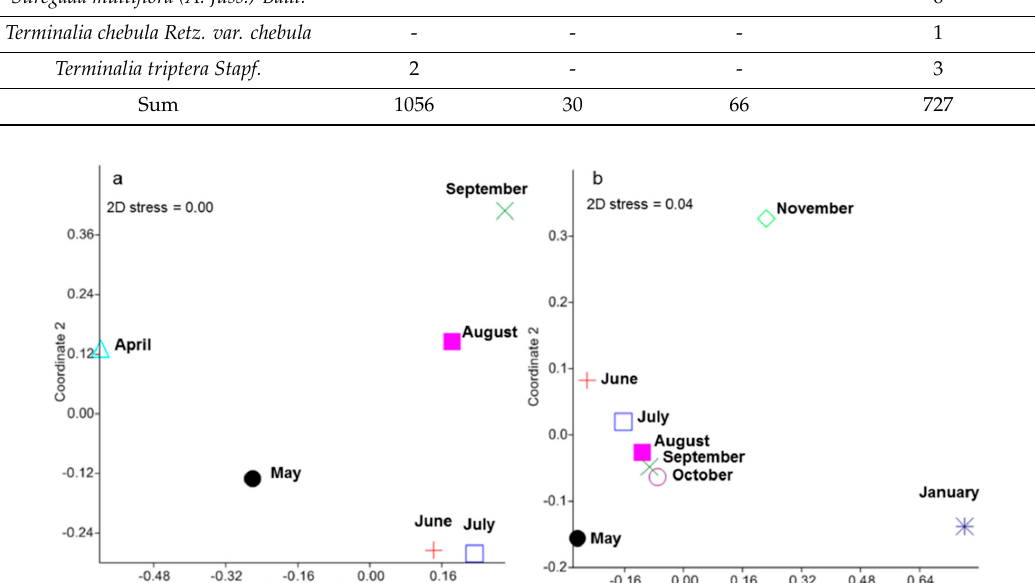
Figure 1. Non-metric multidimensional scaling (NMDS) of changes in the community composition of seed species ( a ) and tree seedling species ( b ) detected in different months.